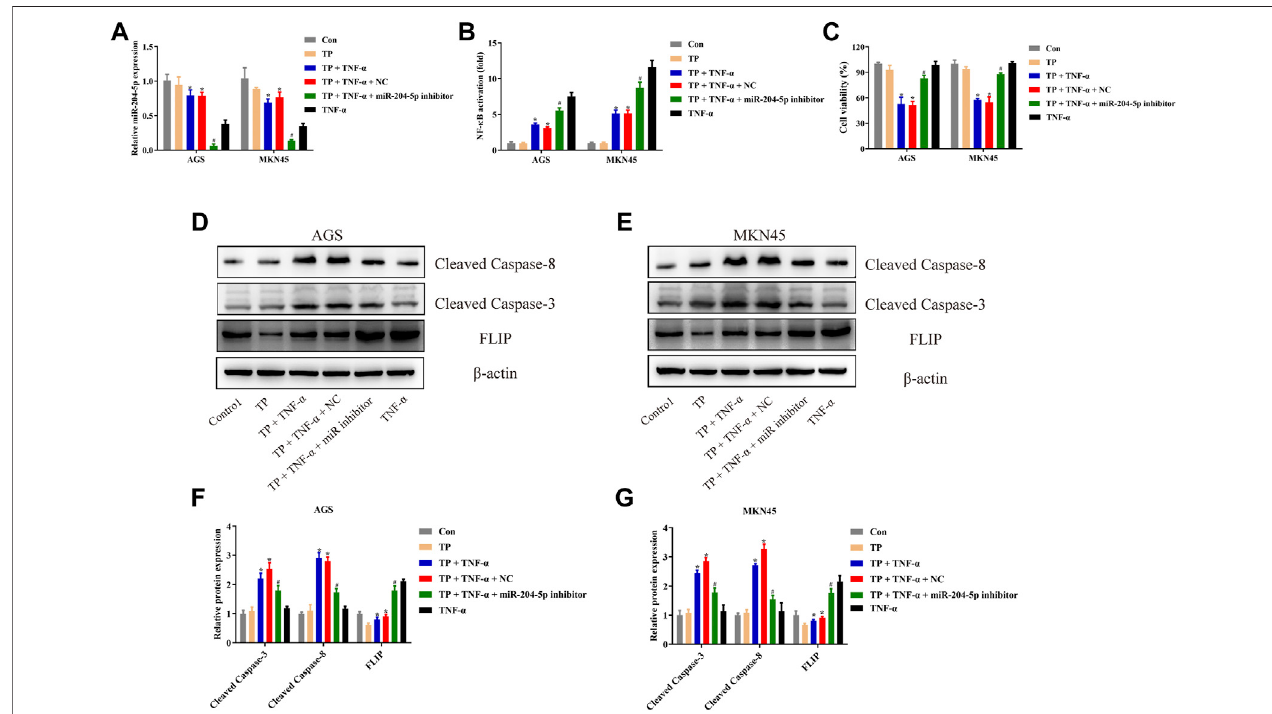
FIGURE 6 | miR-204-5p inhibitor protected AGS and MKN45 cells from TP/TNF- α – induced apoptosis. (A) Relative mRNA expression of miR-204-5p in cells transfected withmiR-204-5p inhibitor and treated withTP (25 nM)and TNF- α (5 ng/ml) for 24h. (B) Relative NF- κ Bactivity ofcells transfected with miR-204-5p inhibitor and treated with TPand TNF- α for 30min. (C) Cell viability ofAGS and MKN45 cells transfected with miR-204-5p inhibitor and treated with TP(25 nM)and TNF- α (5 ng/ ml) for 24 h. (D – G) Representative western blots and relative intensity of protein bands of cleaved caspase-3, cleaved caspase-8, and FLIP in AGS and MKN45 cells transfected with miR-204-5p inhibitor and treated with TP (25 nM) and TNF- α (5 ng/ml), 24 h after TNF- α application, with β -actin as the loading control. Resultswereexpressedasmean±SEM,andstatisticalanalysiswasperformedusingtwo-wayANOVAfollowedbyTukey ’ smultiplecomparisontest.* ,# p < 0.05( n ≥ 3). * p compared with the control group and # p compared with TP/TNF- α /miR-204-5p inhibitor-treated